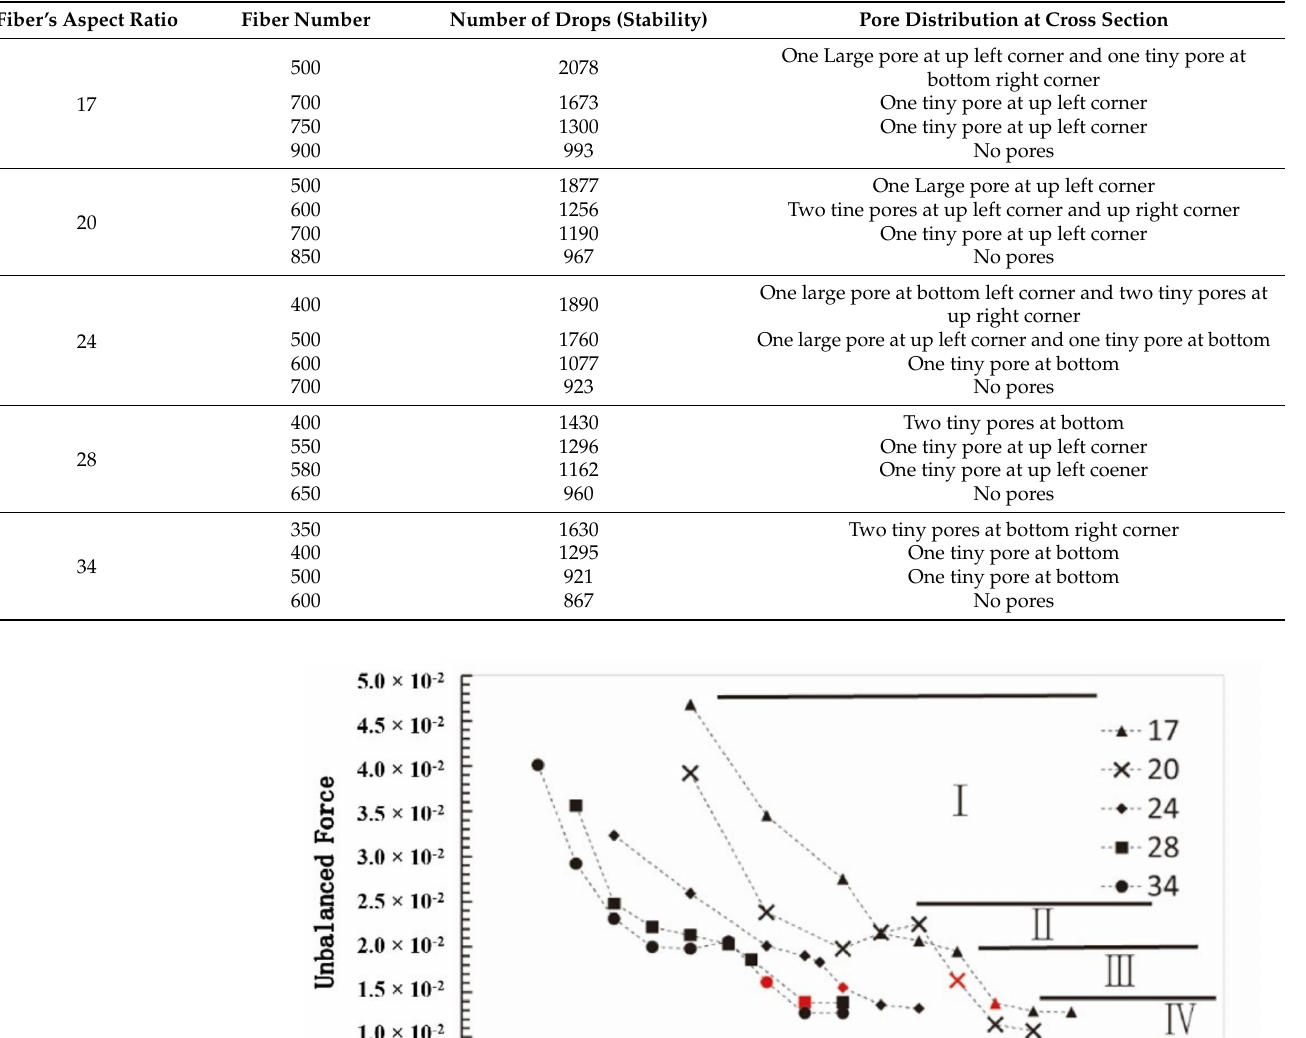
Table 3. The drops number and the pore distribution at cross section at different fiber’s aspect ratio with different fiber number.